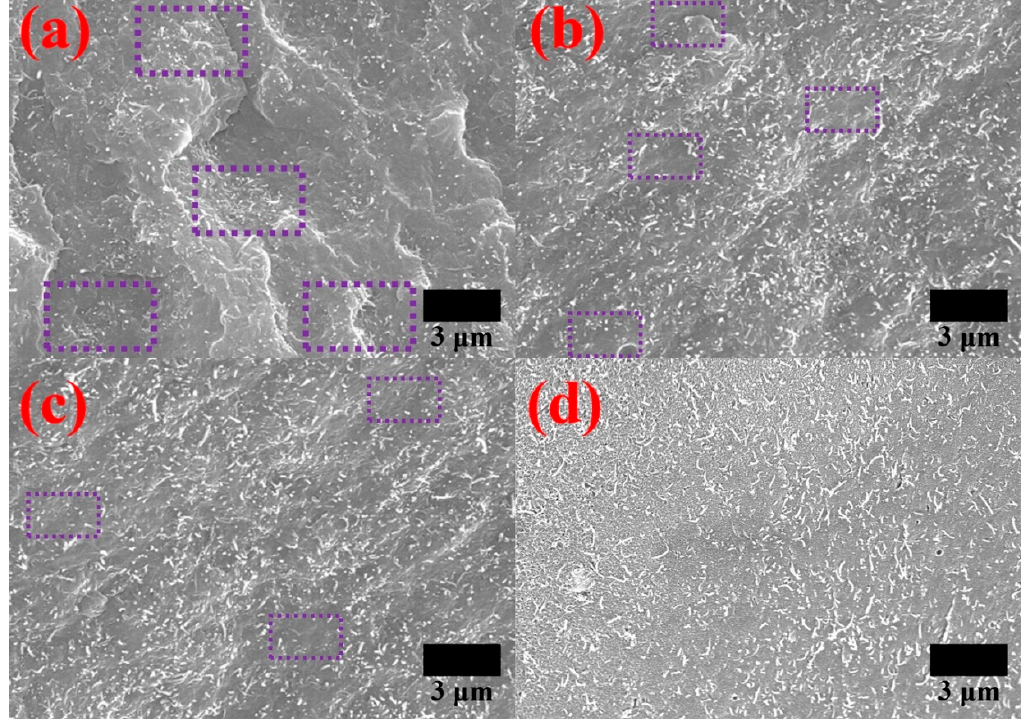
Figure 5. FE-SEM images of the composites filled with ( a ) purified MWCNTs, ( b ) carboxylated MWCNTs, ( c ) isocyanated MWCNTs, and ( d ) PA6-grafted MWCNTs.